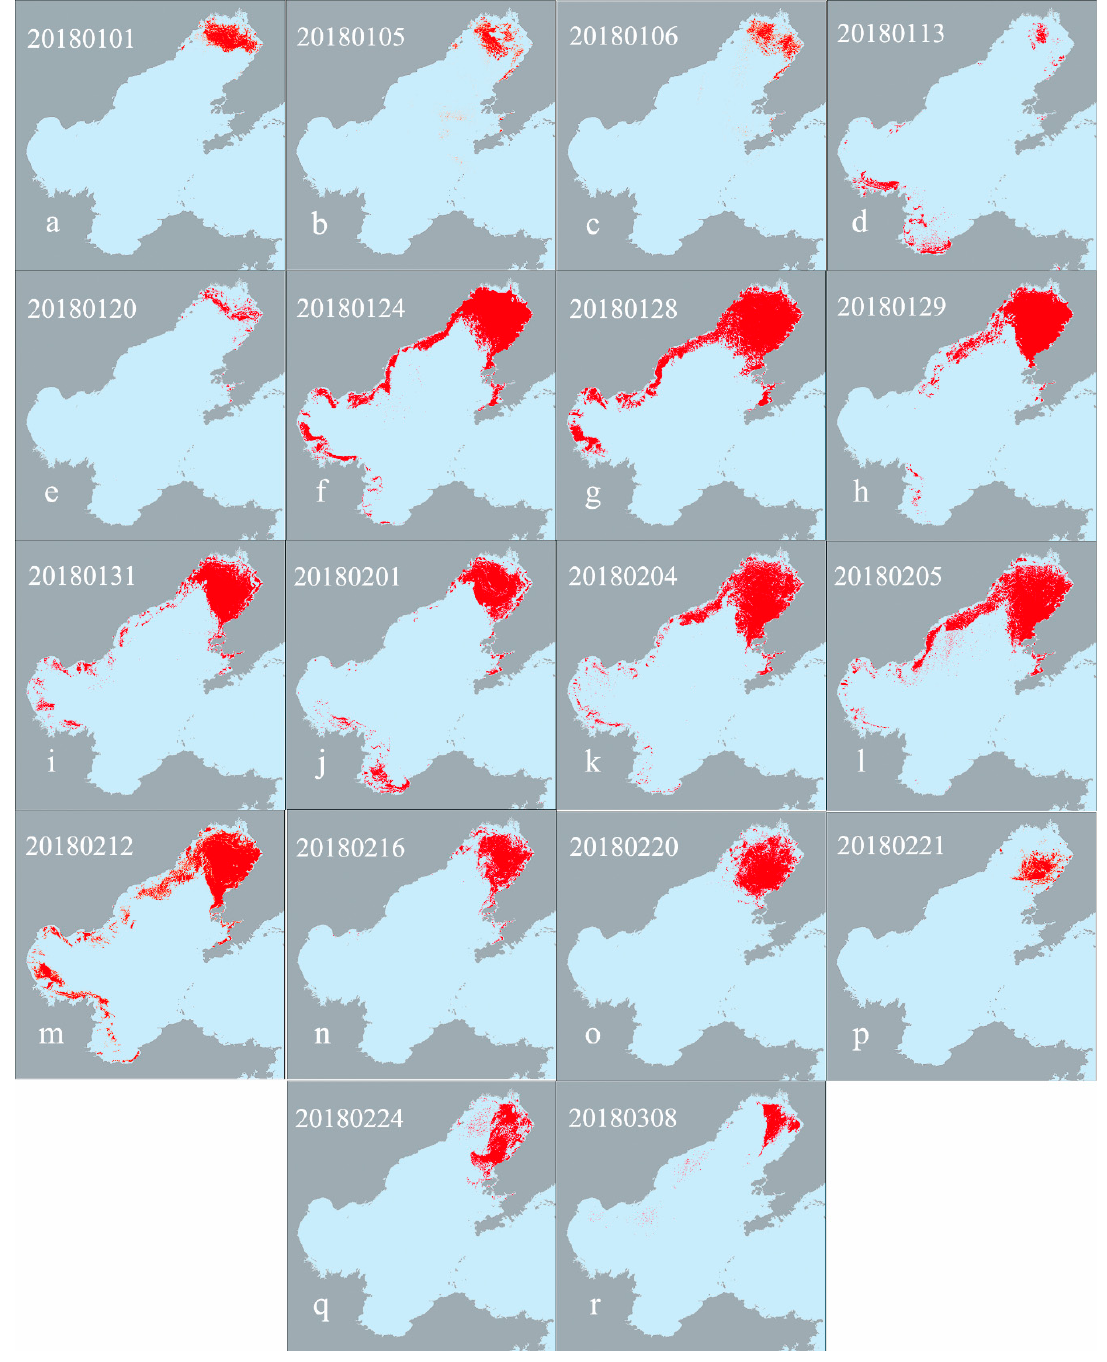
Figure 8. Spatiotemporal evolution of the extent of Bohai Sea ice during the winter of 2017 – 2018 from OLCI images using the ENDSIII OLCI method ( a–r ). Red areas depict sea ice coverage.